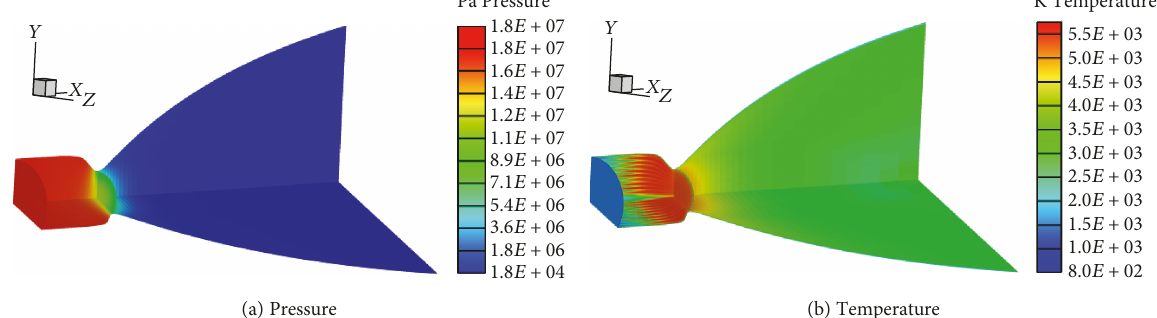
Figure 4: Flow fi elds in the engine using the single-step global chemical reaction.